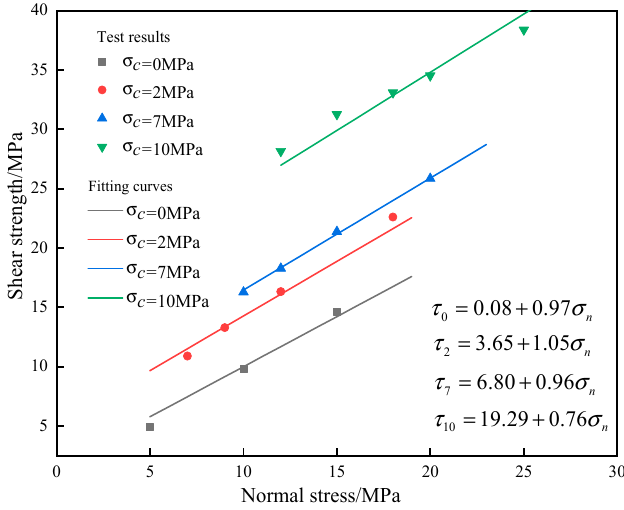
Figure 14. Comparison of the test and fitting results of the relationship between shear strength and normal stress.